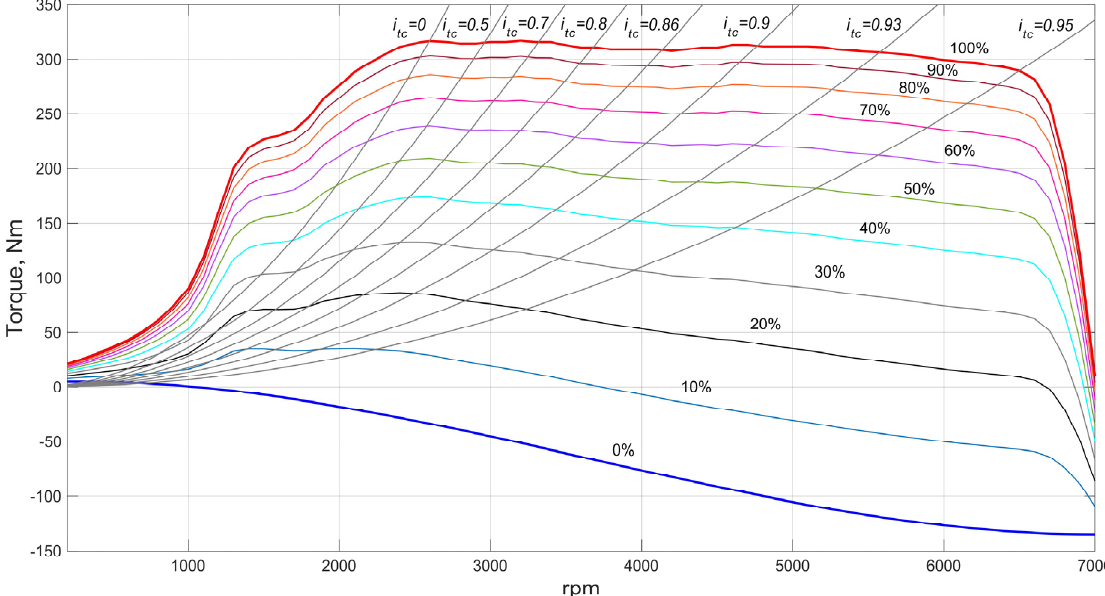
Figure 1. Speed–torque characteristic (map) of the 3.2 FSI engine for each 10% of fuel supply (throttle position) increment, combined with the TC’s impeller loading characteristics.